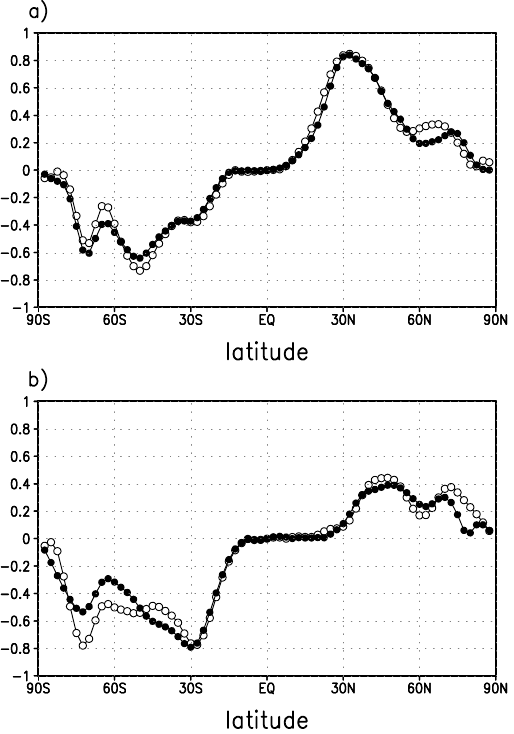
Fig. 11. Same as Fig. 9 but for the shear wind.